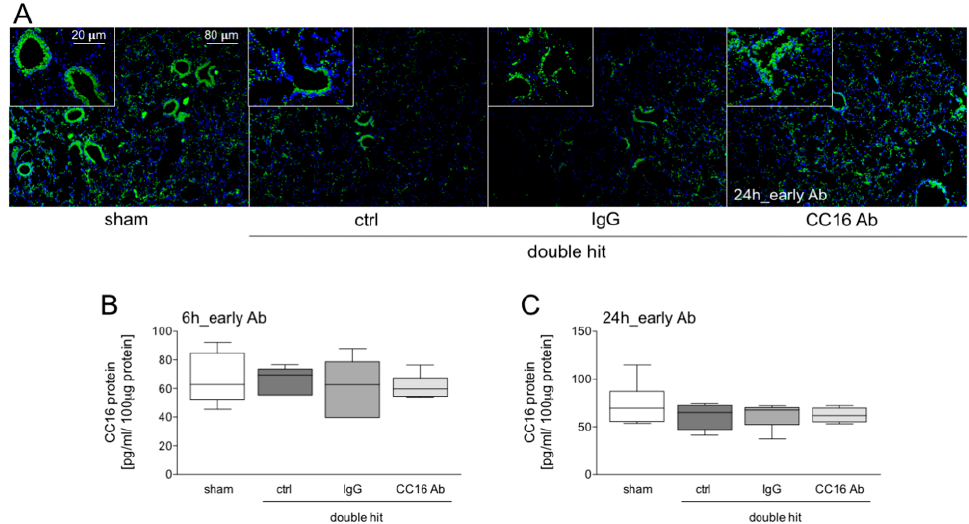
Figure 2. ( A ) CC16 (green) and nuclei (blue, 4 ′ ,6-diamidino-2-phenylindole, DAPI) staining 24 hours after CLP and early interventions with antibodies shows intrabronchial high concentrations of CC16 positive cells. In double-hit groups, a prominent loss of CC16 into the interstitium as well as a loss of the pulmonary integrity is shown. ( B ) Pulmonary CC16 levels are shown in animals with early interventions with either CC16 antibody (Ab) or IgG control (IgG) antibody, at 6 or 24 h post-CLP ( C ) ( n = 8).